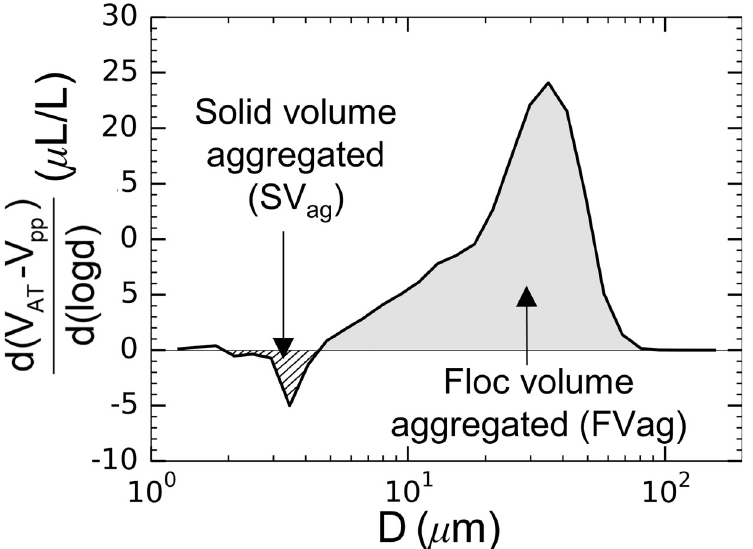
Fig 7. The difference in particle volume between the aggregation tank and the primary particle distribution. This figure illustrates the calculation of the volume of primary particles removed from the population ( SV volume formed due to aggregation ( FV ag